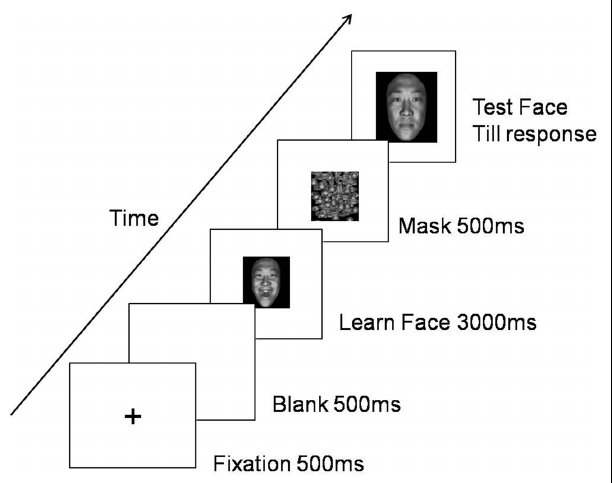
FIGURE 1 | Illustration of the procedure. The test face was either shown in a frontal pose or a side pose.The procedure in the two experiments was identical except that the test face was shown in the same expression as the learning face in Experiment 1, but in a neutral expression in Experiment